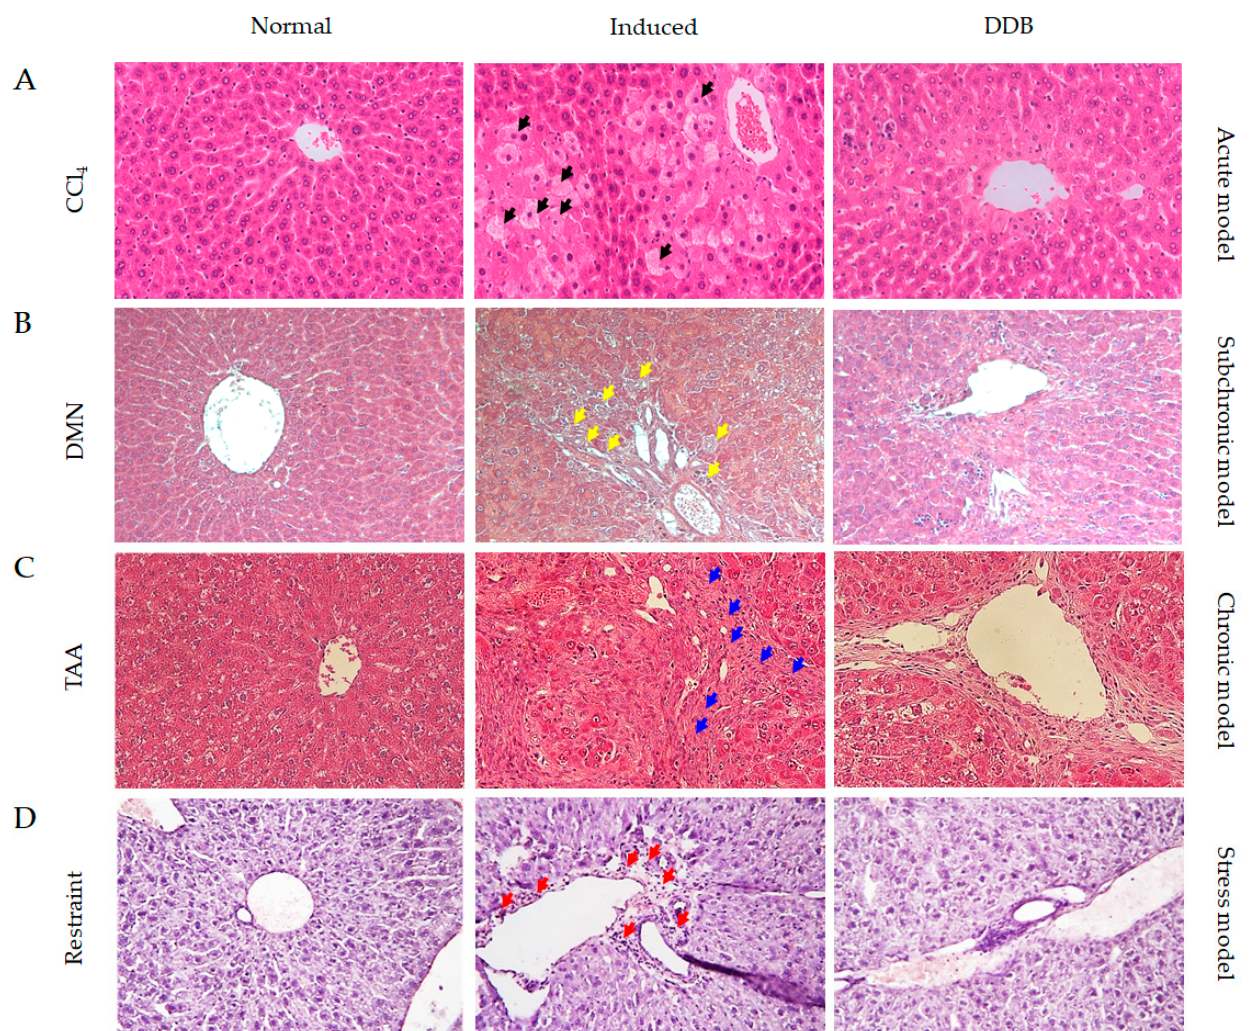
Figure 5. Comparison of hepatic lipid peroxidation and ROS activity in four liver injury models. Formalin-fixed liver tissues from the CCl 4 acute model ( A ), black arrows indicated hepatocyte swelling, DMN subchronic model ( B ), yellow arrows indicated bile duct hyperplasia, TAA chronic model ( C ), blue arrows indicated collagen deposition and restraint stress model ( D ), red arrows showed neutrophil infiltration were embedded in paraffin, sectioned with a microtome, stained with hematoxylin and eosin and mounted in Canada balsam. Histopathological analysis was performed with an Olympus IX71 microscope and an Olympus DP74